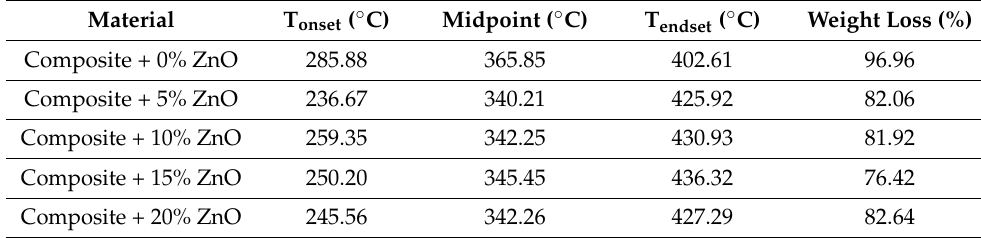
Table 4. Results of the thermogravimetric analysis (TGA) test.